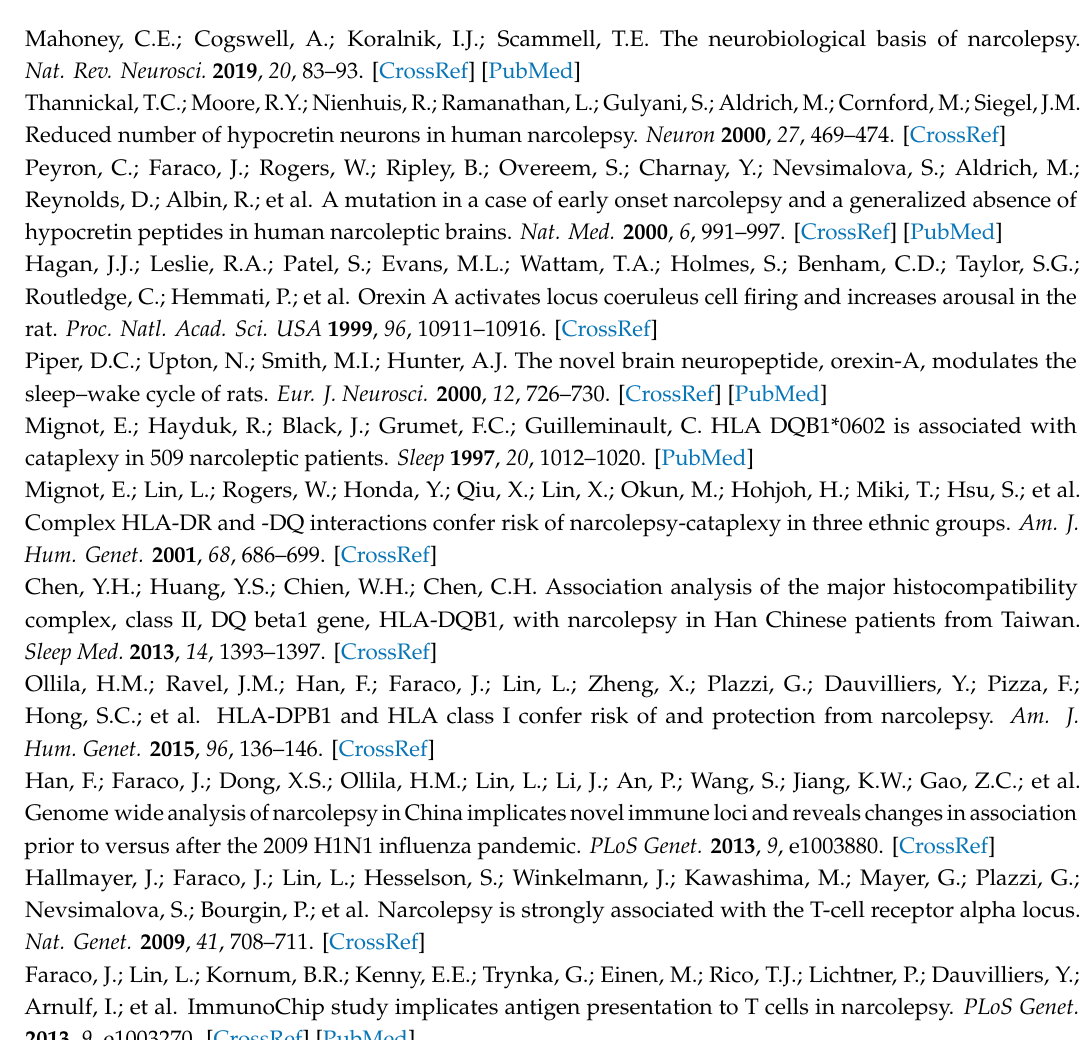
specific CD4 Tcells in narcolepsy cases and controls after stimulation with pandemrix, arepanrix or no stimulation, Table S5: Frequency of Mutated Peptide tetramer specific CD4 Tcells in narcolepsy cases and controls after stimulation with pandemrix, arepanrix or no stimulation, Table S6: All mutated occurences and unmutated occurences extracted from the mapped spectra for all vaccines and lots (Nan—indicated not